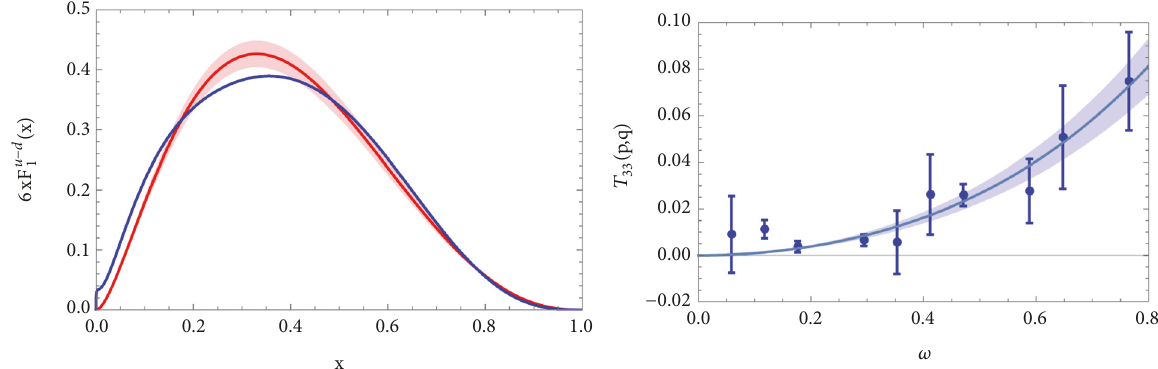
Figure 38: Left: exemplary parametrized PDF (blue) and its reconstruction (red) using the method proposed in [91]. Right: Compton amplitude obtained in an exploratory lattice computation. The solid line is a fit to a sixth order polynomial. Source: arXiv version of [91], reprinted with permission by the Authors (article published under the terms of the Creative Commons Attribution 4.0 International license).